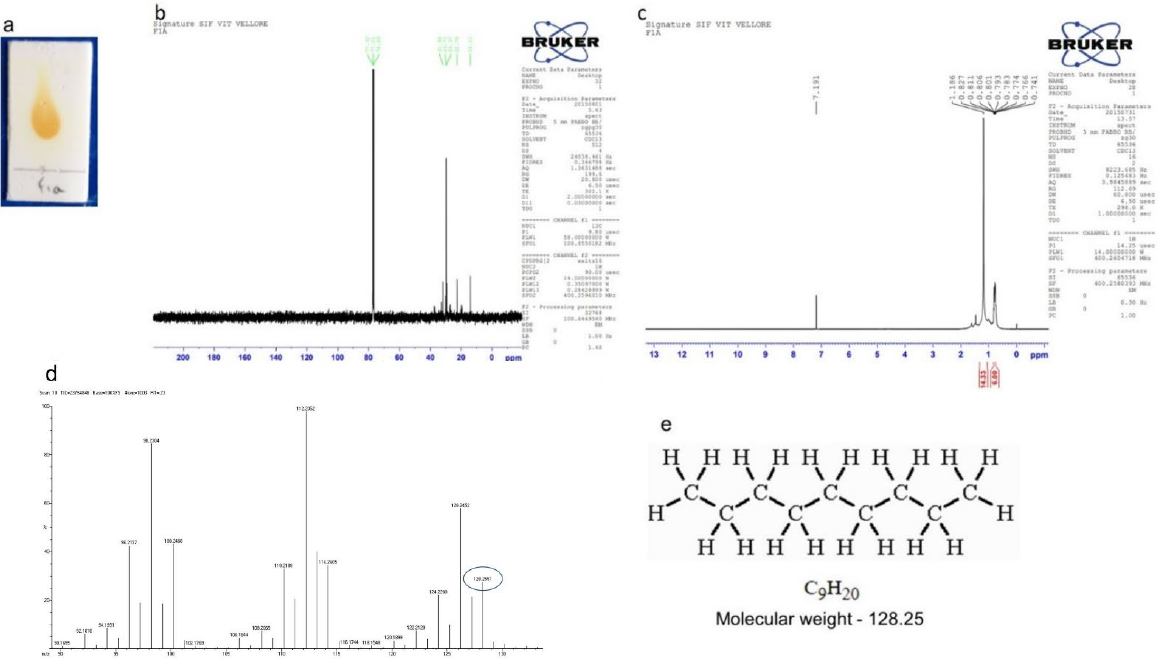
Figure 6. Isolation of compound 1 (Nonane). ( a ) TLC showing a single spot of compound eluted at 100% petroleum ether, ( b ) 13 C NMR, ( c ) 1 H NMR, ( d ) HRMS, ( e ) molecular weight and structure.